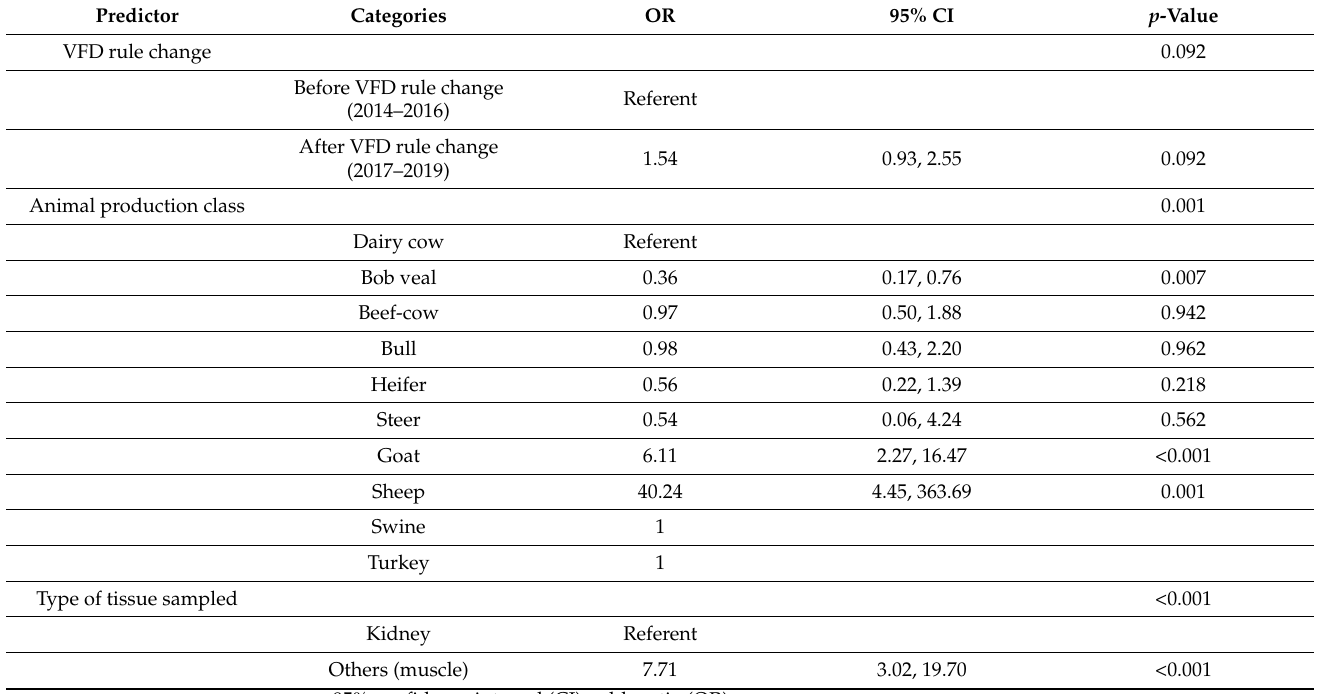
Table 6. Results of multivariable logistic regression for predictors of detection of violative residues of tetracyclines in the tissue of food animals ( n = 960) from the IGS,